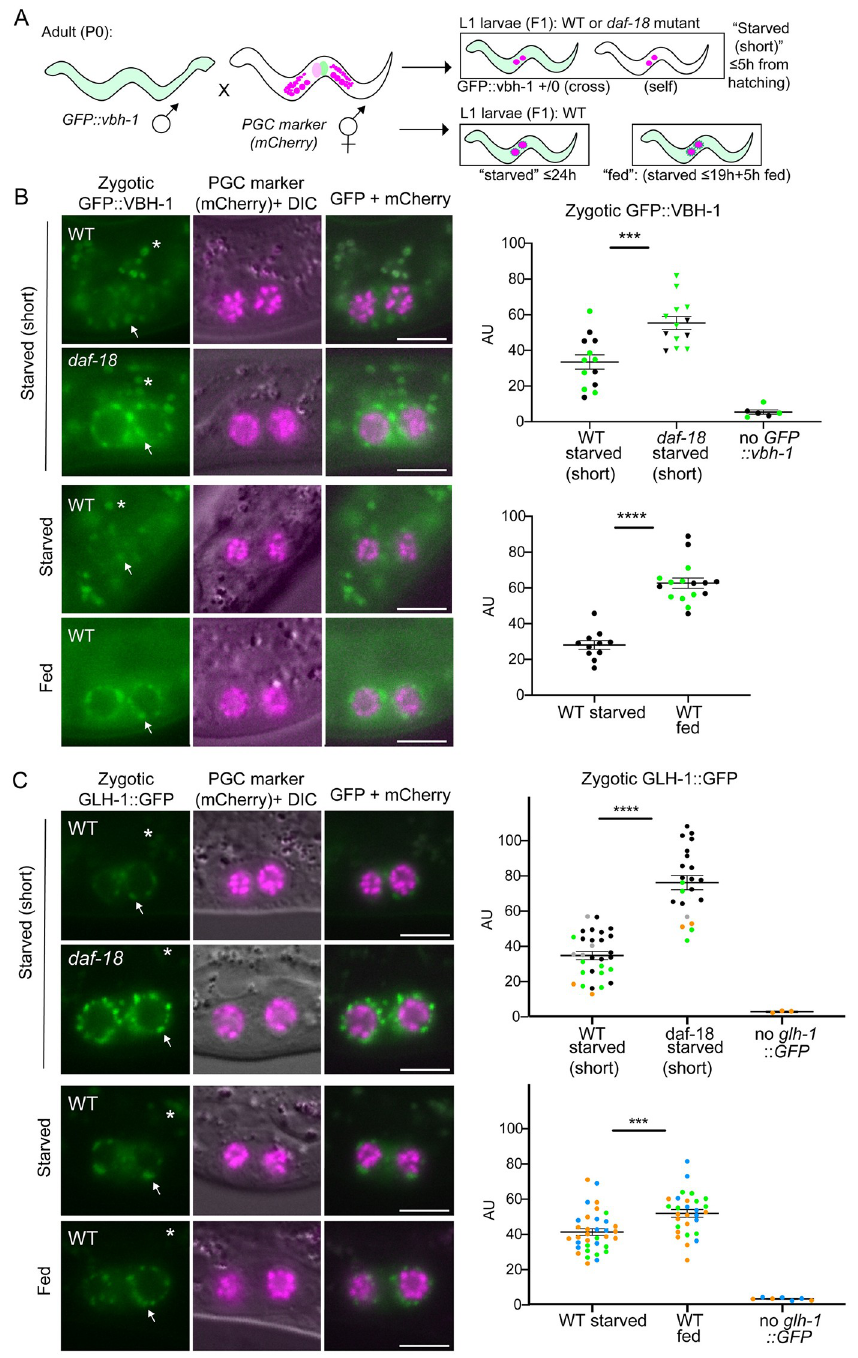
Fig 4. Levels of zygotic VBH-1 and GLH-1 are inappropriately elevated in PGCs of starved daf-18 mutants. (A) Schematic of strategy to observe strictly zygotic expression of germline genes vbh-1 and glh-1 , tagged with GFP. Single- copy GFP inserted into endogenous vbh-1 or glh-1 loci was crossed from the male into PGC :: mCherry hermaphrodites. Crosses were performed in either the wild type (WT) or daf-18(ok480) mutant background. “Starved (short)” L1 progeny were imaged up to 5 hours after hatching (with no food). “Starved” progeny were collected and imaged up to 24 hours after clean embryo preparation, while “fed” L1 progeny were similarly imaged at 24 hours ( � 24 hours), but the last 5 hours prior to imaging, they were on food (up to 19 hours starved + 5 hours fed; (see Methods). (B) Representative images taken within 1 hour of hatching. Arrows point to zygotic perinuclear GFP::VBH-1 in PGCs. Exposure time is longer in B than in C, so gut granules (green auto-fluorescent dots, marked with asterisks and visible in DIC) are more prominent. Graphs show the results of two experiments pooled together (dots color-coded